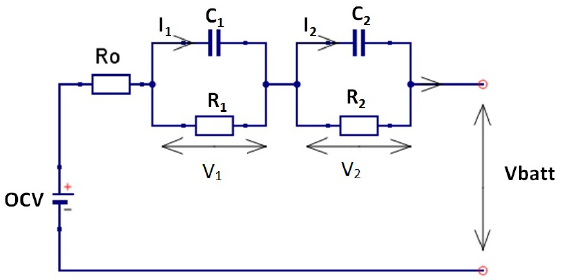
Figure 4. Schematic of the second-order Thévenin model